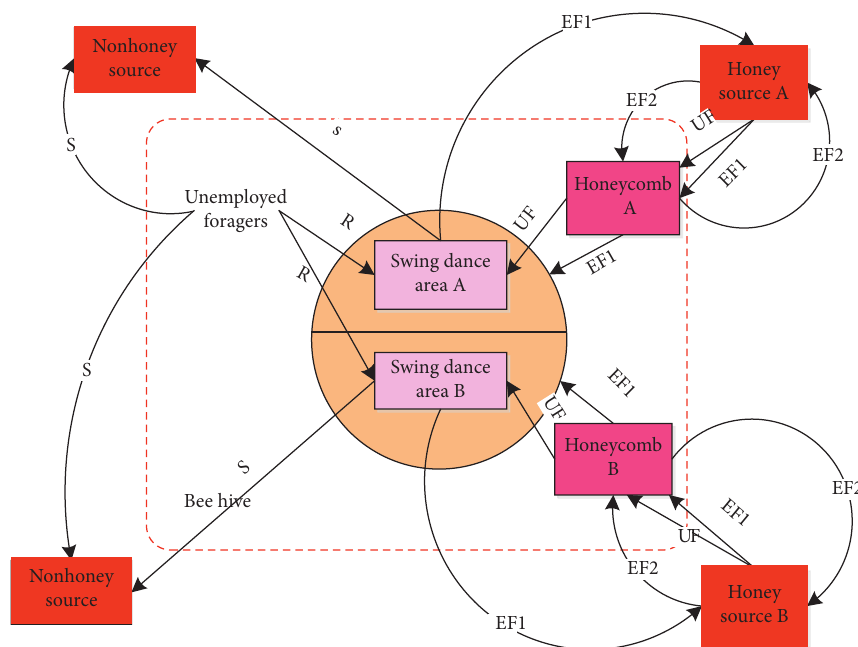
Figure 1: The working diagram of the bee colony collection.